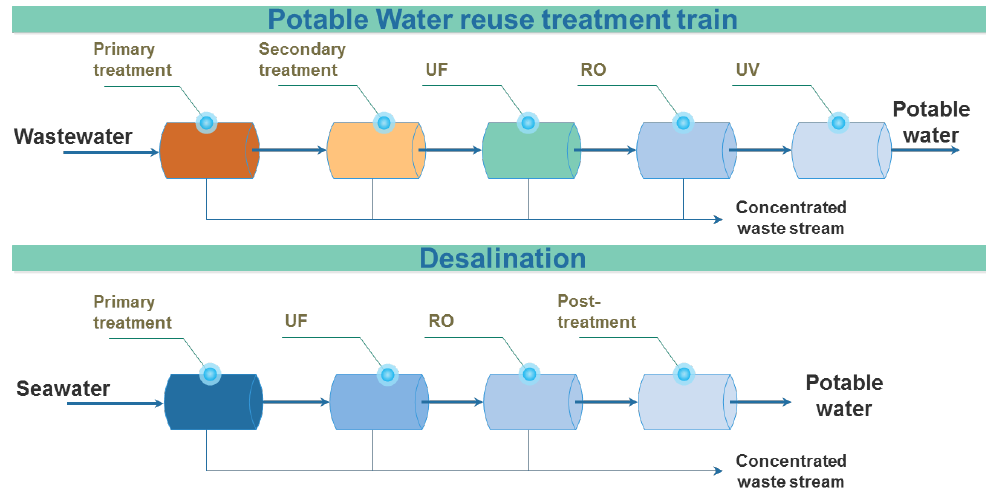
Figure 1. Examples of typical potable water reuse and desalination treatment trains, based on case studies in [18,26].